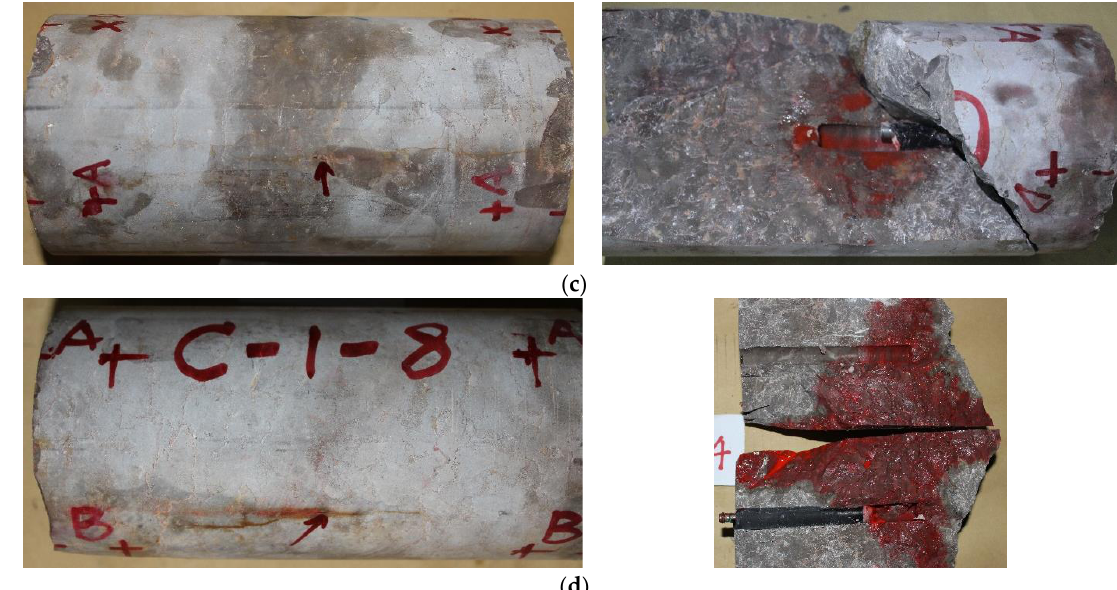
Figure 7 . Failure modes with different fracturing fluid: ( a ) Slick water; ( b ) guar gum; ( c ) cross-linked; ( d ) gelled acid.